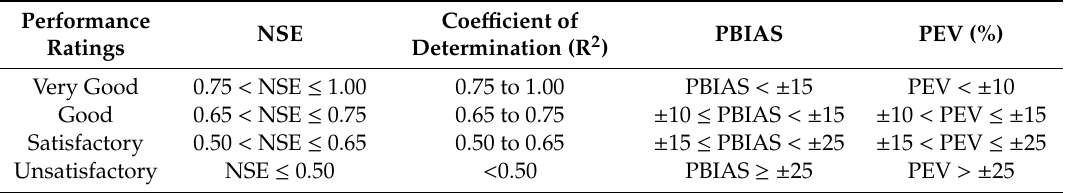
Table 4. General performance ratings for recommended